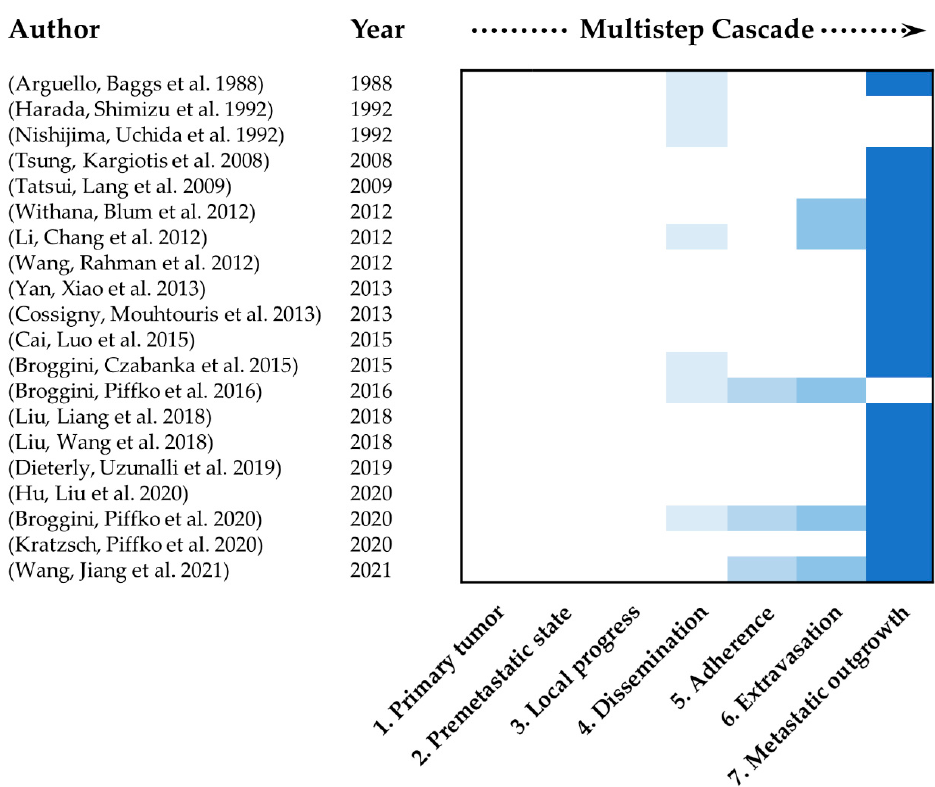
Figure 2. Allocation of the main study focus according to the corresponding step of multistep cascade of metastasis. Only studies listed in Table 1 of this review were included. Steps were defined as follows: 1. Primary tumor, 2. Premetastatic niche pre-colonization, 3. Local invasion and intravasation, 4. Circulation, dissemination and survival, 5. Adherence and arrest in a new organ, 6. Extravasation into the surrounding tissue, 7. Initiation and maintenance of growth and vascularization